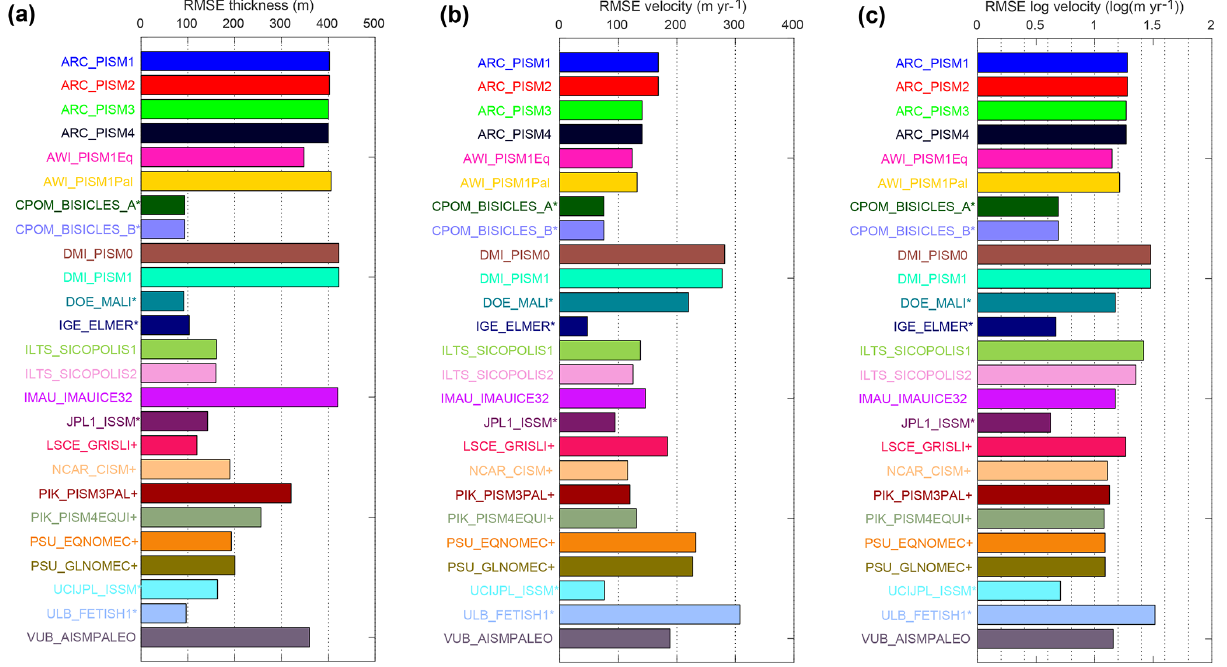
Figure 3. Root mean square error (RMSE) of modeled initial conditions compared to observations for (a) initial ice thickness (m), (b) initial ice surface velocity (myr − 1 ) over the ice sheet and ice shelf, and (c) the logarithm of the initial ice surface velocity (log(myr − 1 )). Please note that the model–color relationship used in this figure is applied in all subsequent figures. Models that assimilate present-day conditions during their initialization process are denoted with + if they integrate geometry and ∗ if they integrate velocity and geometry